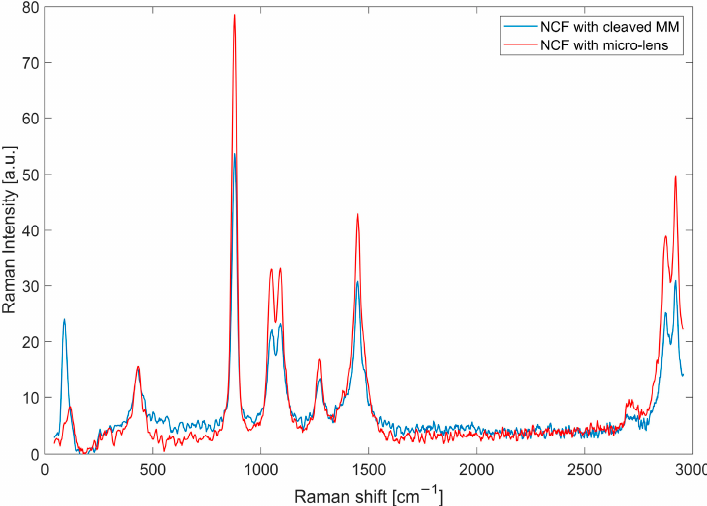
Figure 4. Ethanol spectrum after background removal and smoothing for a cleaved MM probe and a micro-lens probe.